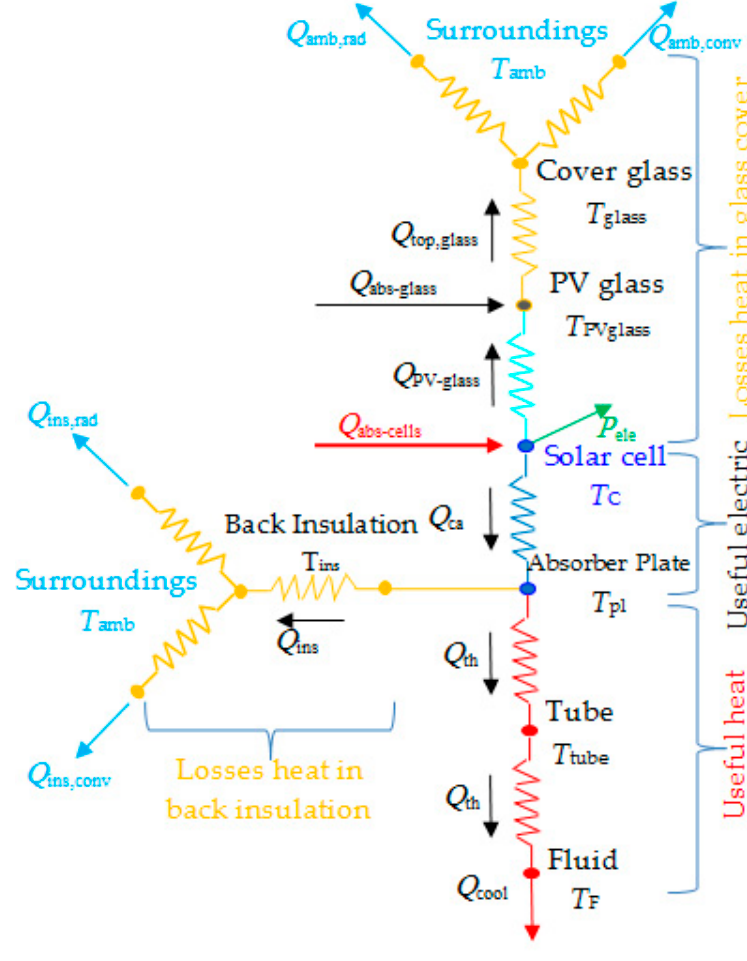
Figure 2. Thermal network describing a CPVT collector.